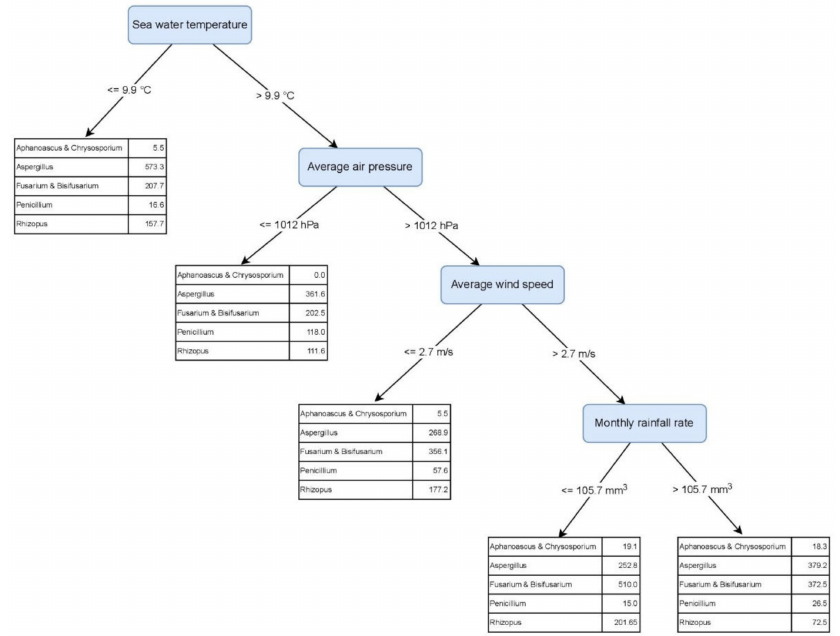
Figure 3. Presence and numbers of “core-genera” in sand samples during the period of 12 months. The official bathing season is indicated with a black, dashed square.